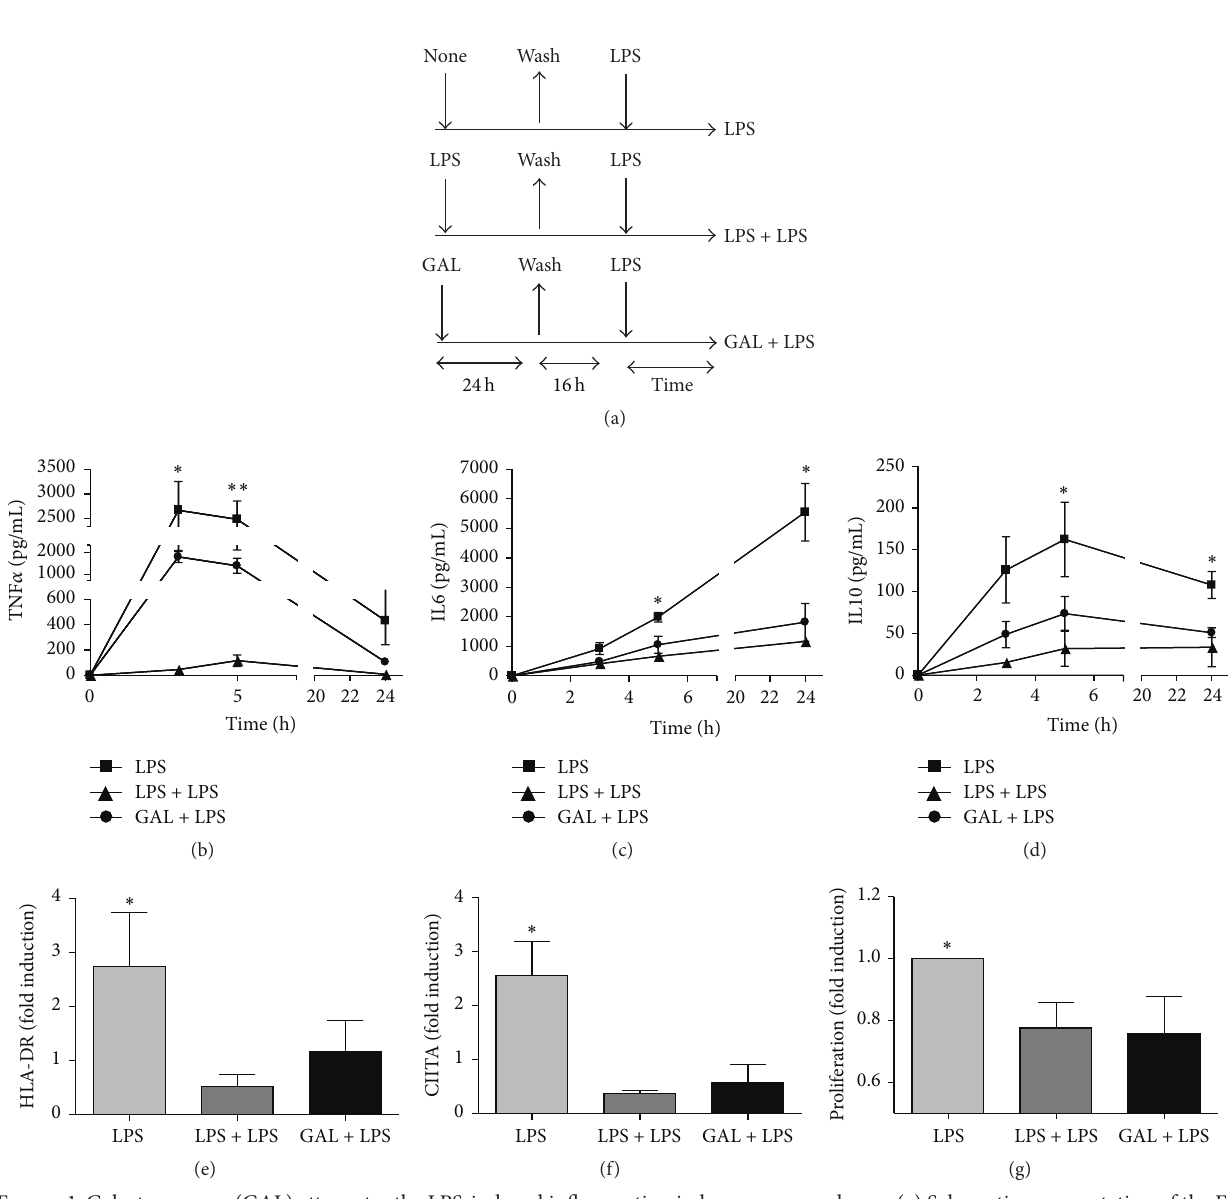
Figure 1: Galactomannan (GAL) attenuates the LPS-induced inflammation in human macrophages. (a) Schematic representation of the ET model used for this study. The cultures of human macrophages were or not pretreated with 10ng/mL LPS or 10 𝜇 g/mL GAL for 24 h, washed twice with PBS, cultured in medium for 16h, and restimulated with 10 ng/mL LPS for the indicated times. Supernatants were harvested at the indicated times (3h, 5h, and 24 h) and TNF 𝛼 (b), IL6 (c), and IL10 (d) proteins levels were evaluated by CBA ( 𝑛 = 5 ); ∗ 𝑝 < 0.05 , ∗∗ 𝑝 < 0.01 comparing GAL + LPS with LPS. (e) Cell surface expression of HLA-DR was analyzed by flow cytometry. ( 𝑛 = 5 ), ∗ 𝑝 < 0.05 , comparing GAL + LPS with LPS 24 h. (f) Total mRNA was isolated from cells, cDNA was synthesized and CIITA real-time quantitative PCR was performed. ( 𝑛 = 4 ), ∗ 𝑝 < 0.05 comparing GAL + LPS with LPS 24 h. (g) Human heterologous lymphocytes were labeled with the membrane stain PKH2 Green Fluorescent Cell Linker Kit (Sigma-Aldrich) and cocultured with LPS, LPS + LPS, or GAL + LPS macrophages for 5 days. Lymphocyte proliferation was measured as a loss of green fluorescence intensity in the CD3 + gate, for this analysis. The fold induction is shown. ∗ 𝑝 < 0.05 , comparing GAL + LPS with